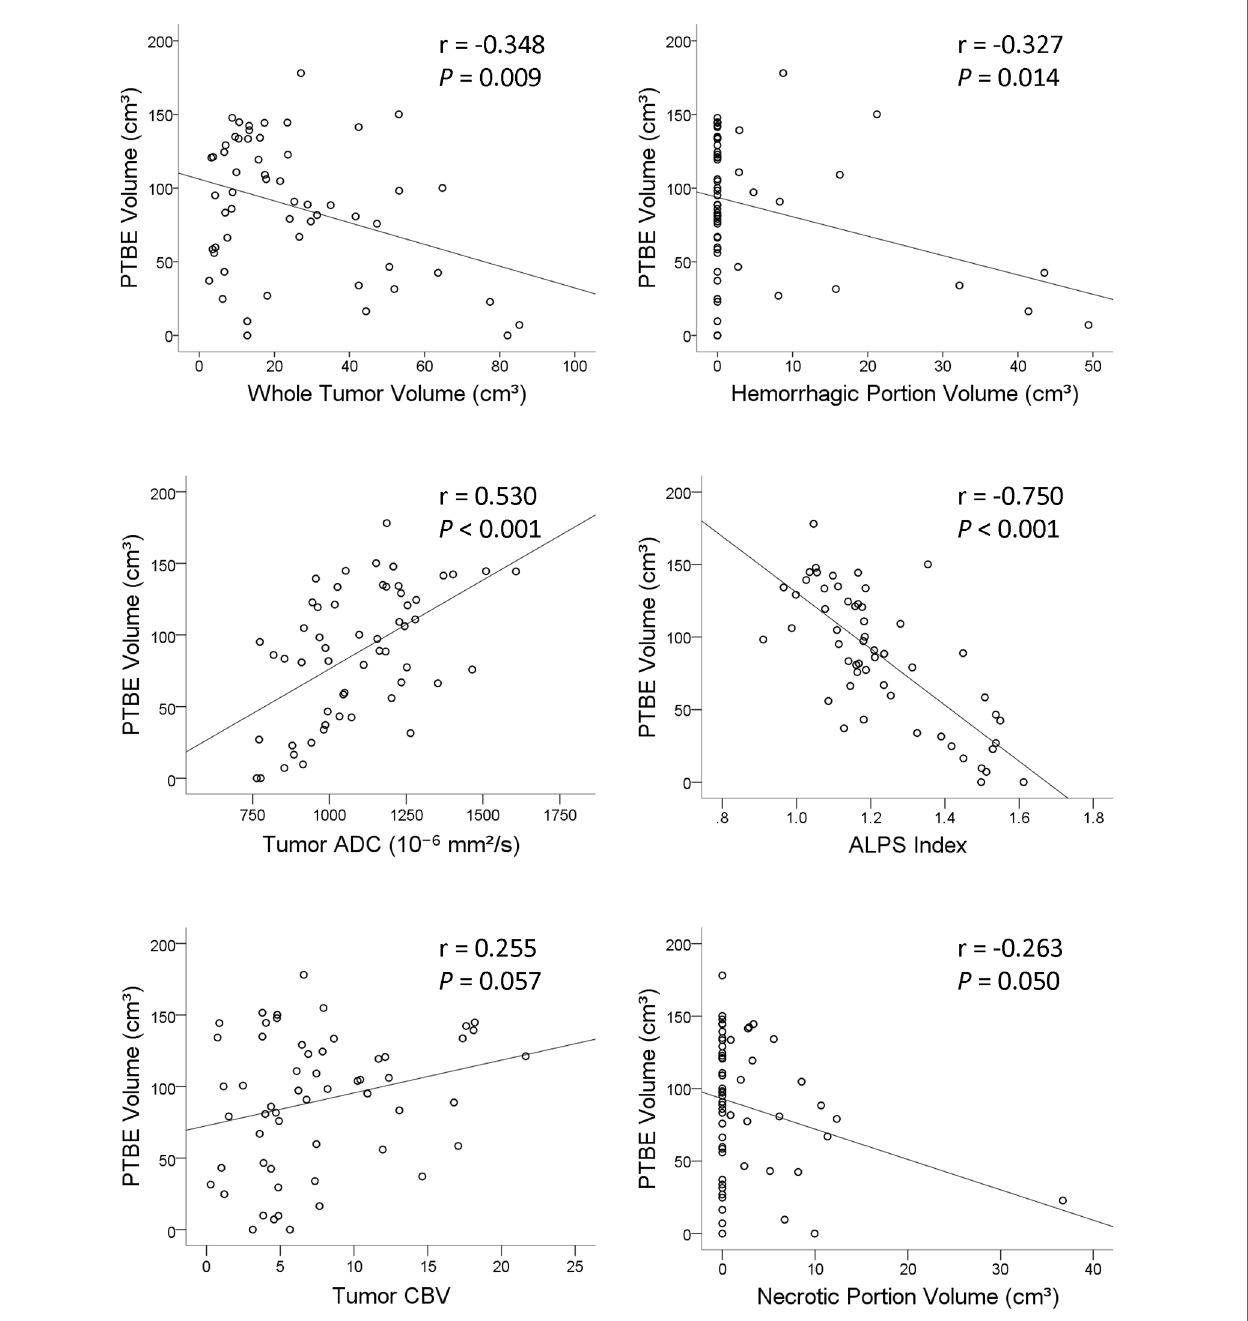
FIGURE 3 | Scatterplots with regression line showing the correlations of the peritumoral brain edema volume of metastatic brain tumors with whole tumor volume, hemorrhagic portion volume, tumor apparent diffusion coef fi cient, analysis along the perivascular space index, tumor cerebral blood volume, and necrotic portion